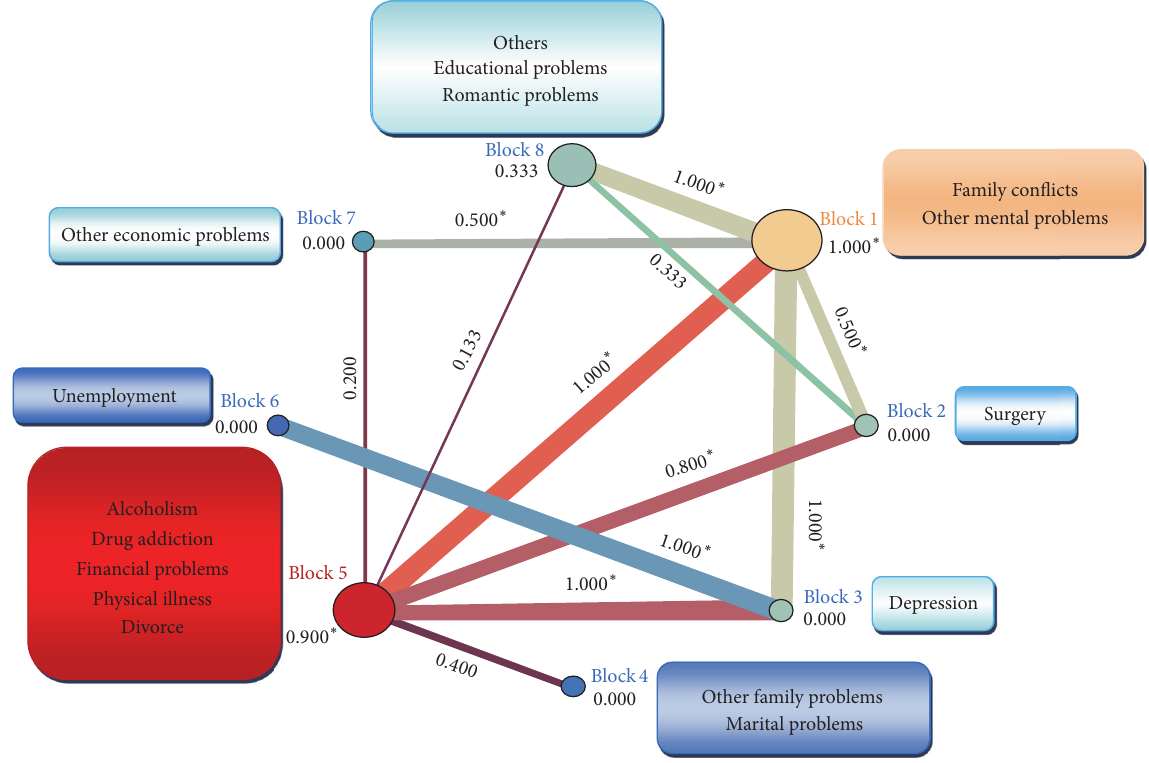
Figure 4: Block modelling in the network of problems preceding deliberate self-poisoning among men. ∗ Density scores higher than the score of whole